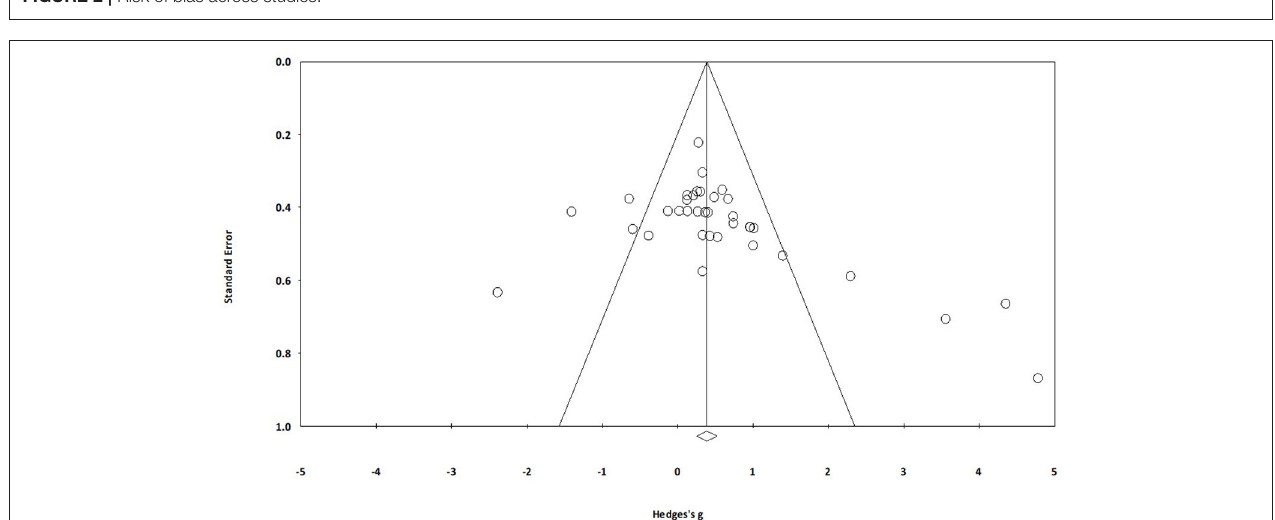
FIGURE 3 | Funnel plot for Hedge’s g and standardized effect for each value in the meta-analysis. Each of the effect is represented in the plot as a circle. Funnel boundaries represent area where 95% of the effects are expected to lie if there were no publication biases. The vertical line represents the mean standardized effect of zero. Absence of publication bias is represented by symmetrical distribution of effect’s around the mid-line.